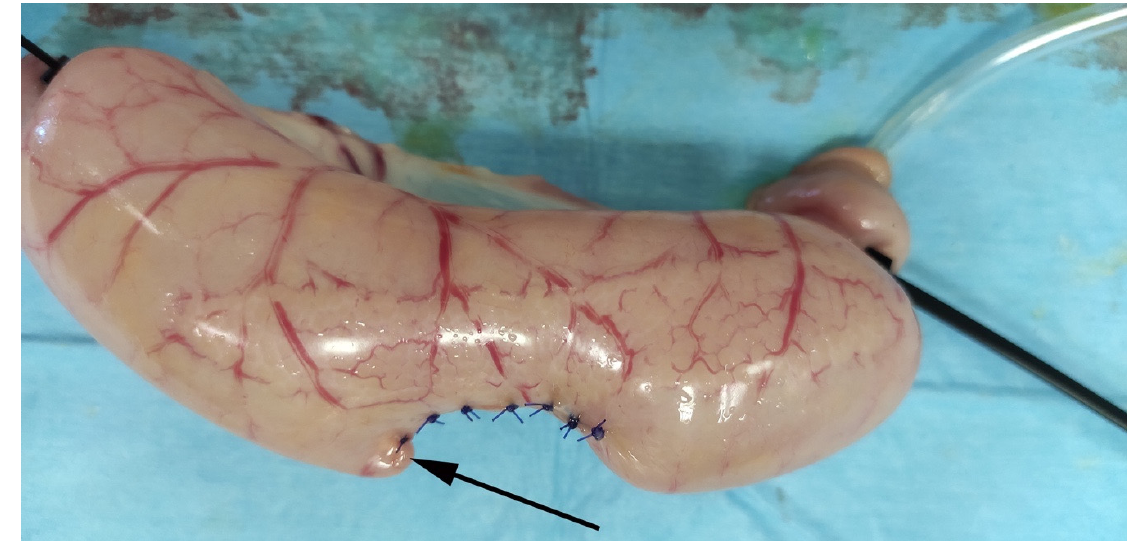
Figure 8. Representative image of the group suture construct during the BP test in study arm 2. The black arrow shows the failure site.